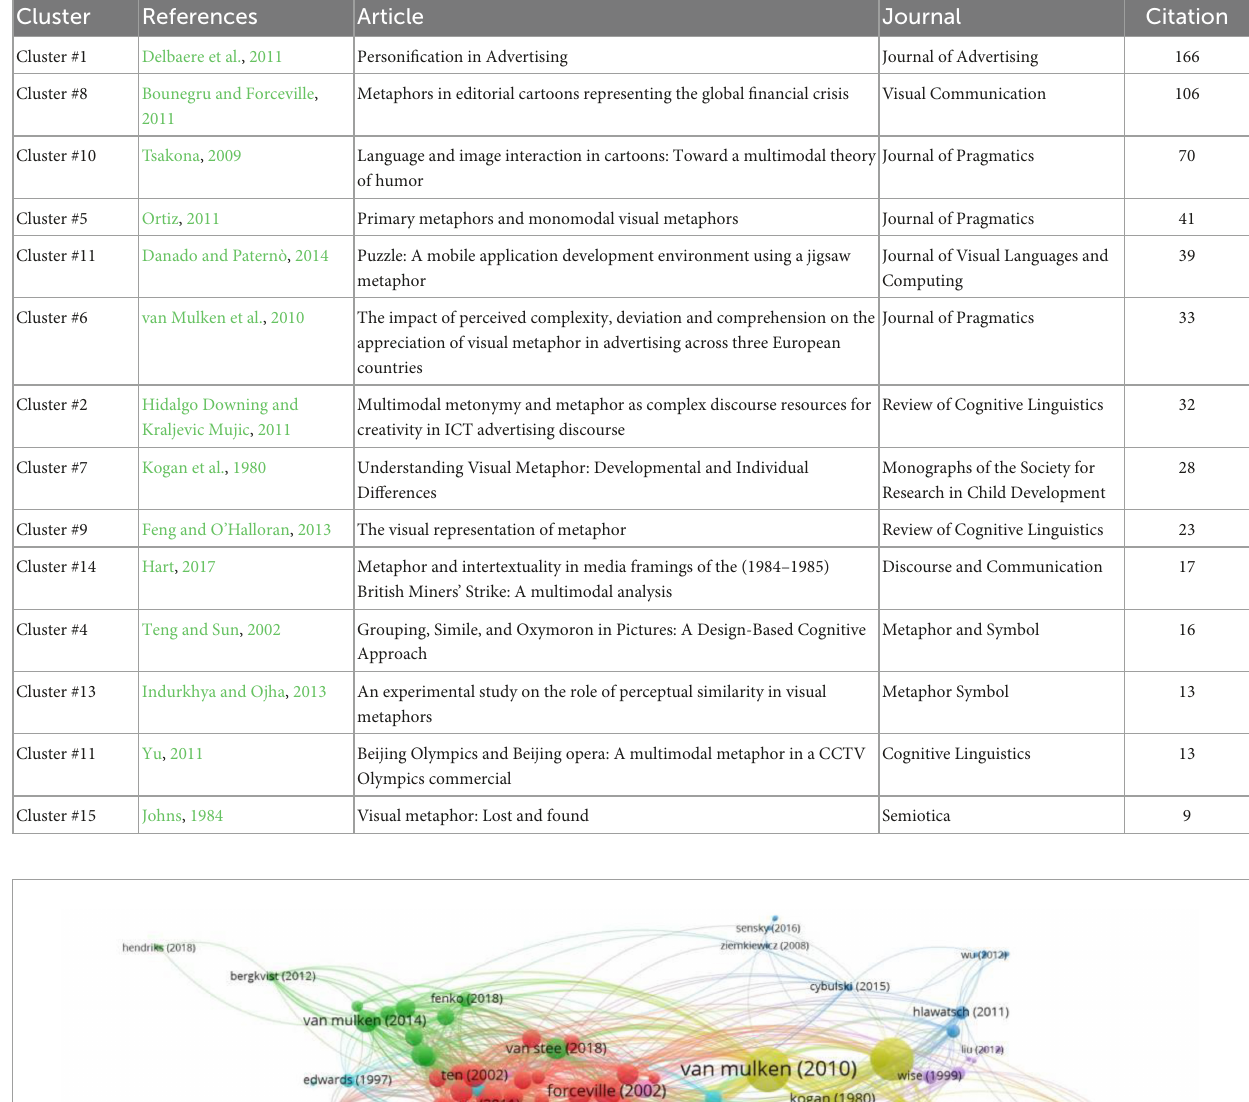
TABLE 4 The representative document in the 15 clusters according to citation analysis.